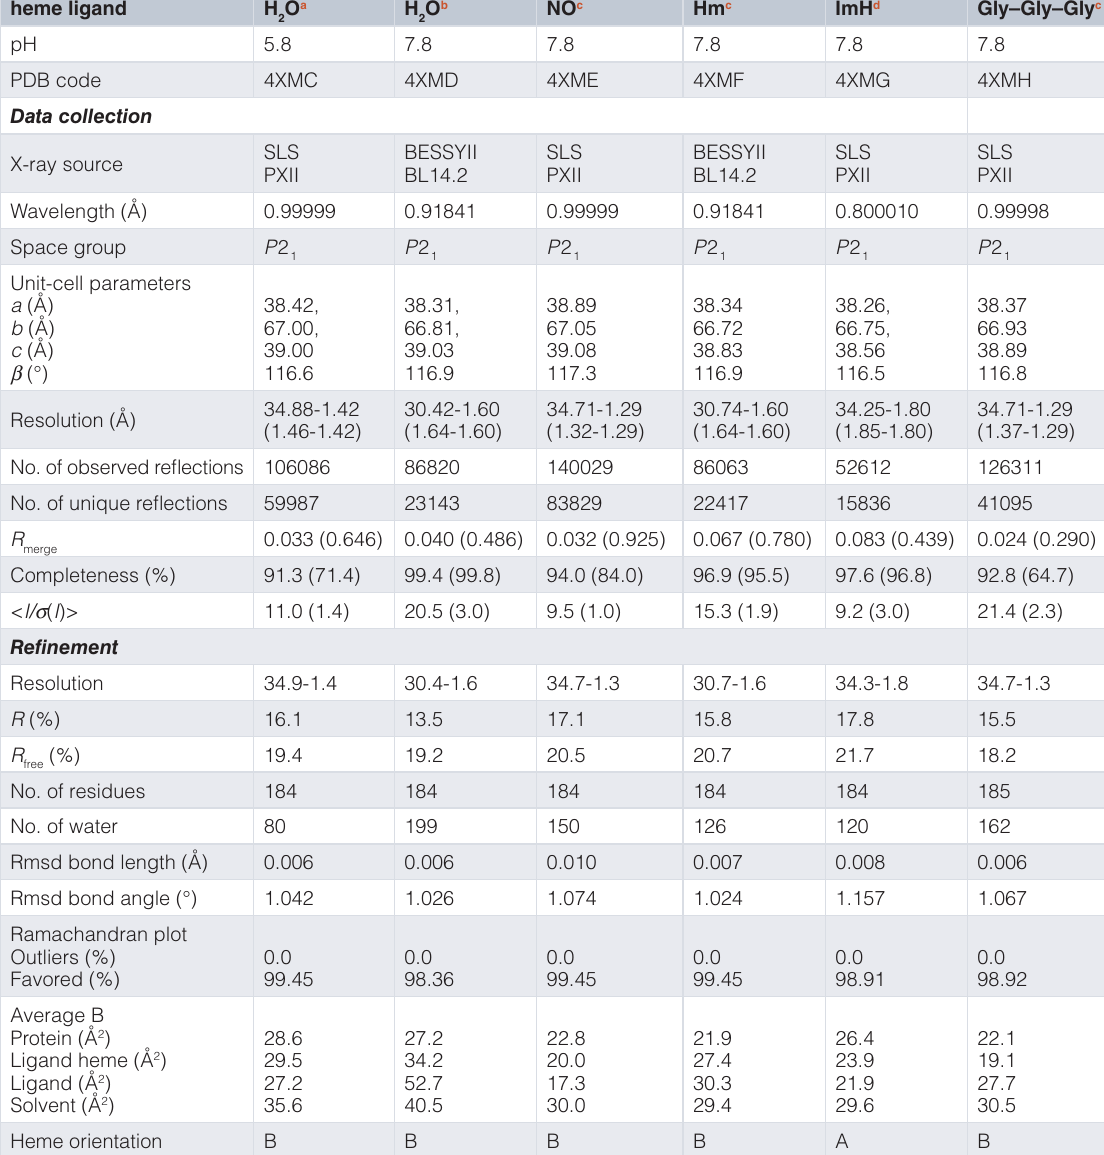
Table 1. Refinement statistics of the crystal structures of NP7 obtained with various heme ligands and under various crystallization conditions. The highest resolution shell is shown in